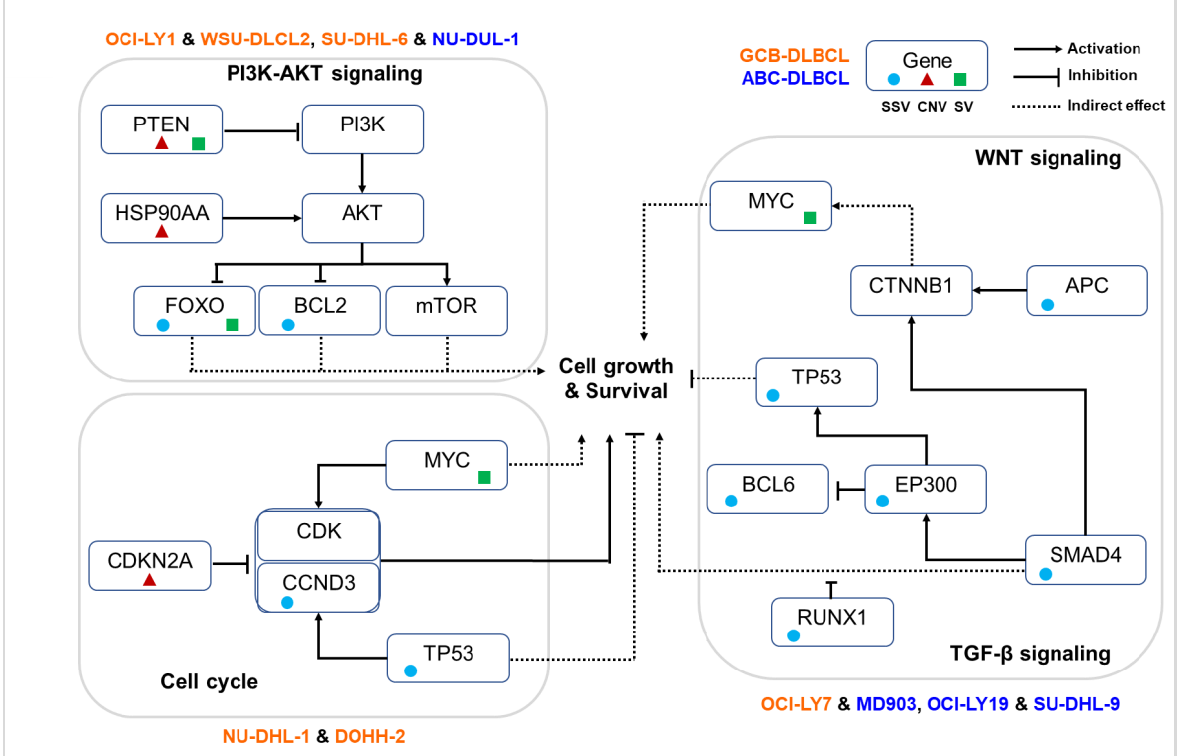
Figure 6. Key pathways disrupted in different sets of DLBCL cell lines according to their shared genetic variations.